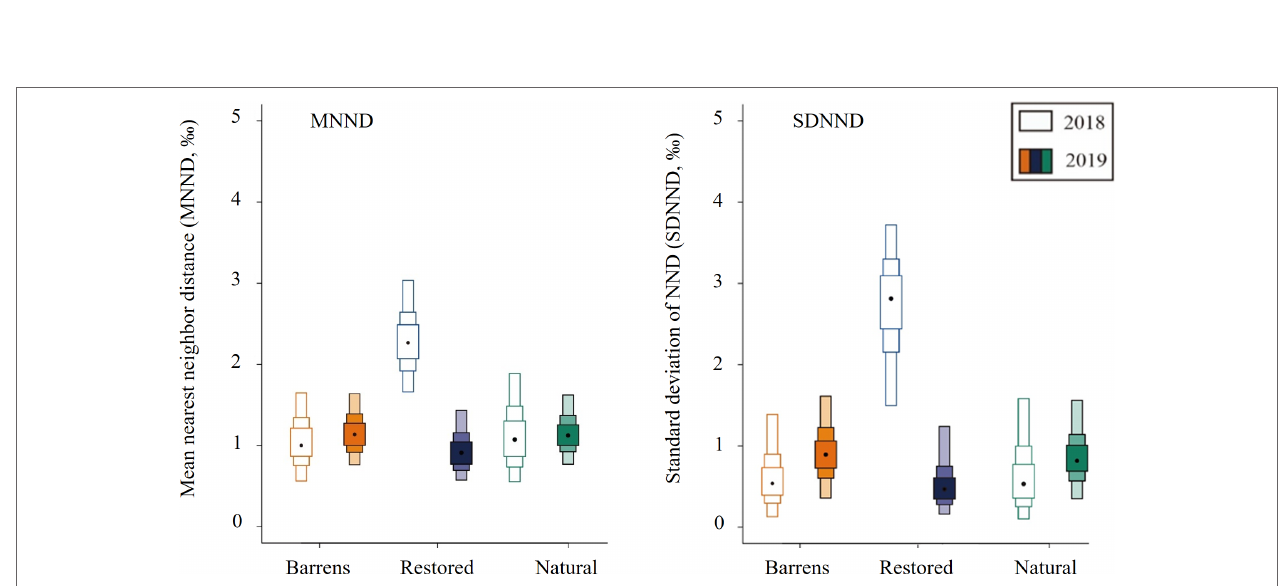
FIGURE 6 | Three of the community metrics and SEA inferred by Bayesian, providing information on trophic diversity within a food web—CR ( δ 13 C range = maximum δ 13 C − minimum δ 13 C, ‰), NR ( δ 15 N range = maximum δ 15 N − minimum δ 15 N, ‰), SEA (standard ellipse areas, calculated from the variance and covariance of δ 13 C and δ 15 N, ‰ 2 ), and the mean CD (distance to the centroid, calculated from the mean Euclidian distance of each individual to the δ 13 C– δ 15 N centroid for target population or community, ‰). Black dots indicate the mode. Boxes indicate 50, 75, and 95% of credibility intervals for each site (shown in axis) and year 2018 data and 2019 data are represented by empty squares and colored squares, respectively.